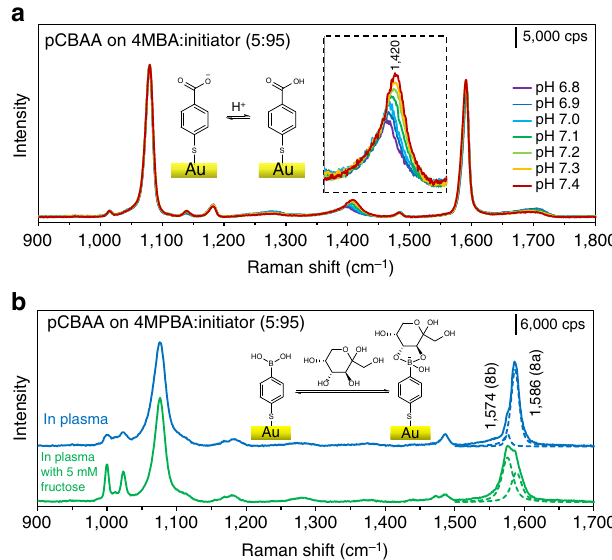
Figure 5 | Hierarchical pCBAA surface modification with probing molecules to enable pH and fructose detection in undiluted human plasma. ( a ) SERS spectra of 4MBA responding to pH-adjusted undiluted human plasma flowed over the hierarchically modified substrate with pCBAA grafted on the mixed SAM of 4MBA and initiator (5:95). ( b ) SERS spectra of 4MPBA responding to undiluted human plasma and plasma spiked with 5mM fructose, flowed over the hierarchically modified substrate with pCBAA grafted on the mixed SAM of 4MPBA and initiator